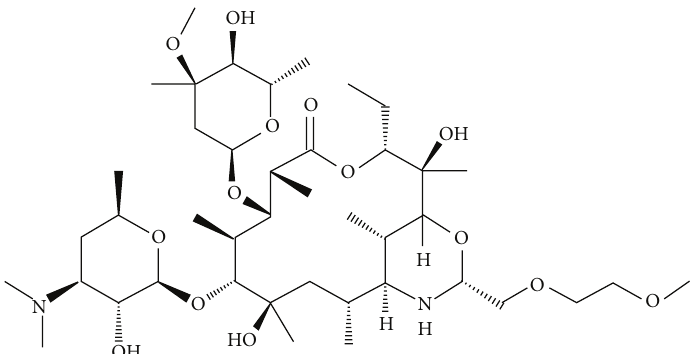
Figure 1: The chemical structure of